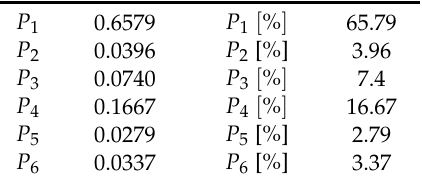
Table 8. Values of limit probabilities P j of the 6-state